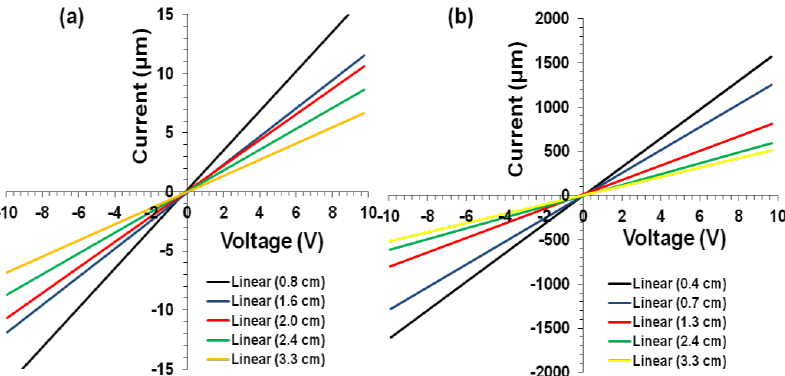
Figure 11. Current-voltage (I-V) plots obtained using five different lengths for ( a ) IC-MWNT and ( b ) G-MWNT inks printed on glass substrate.